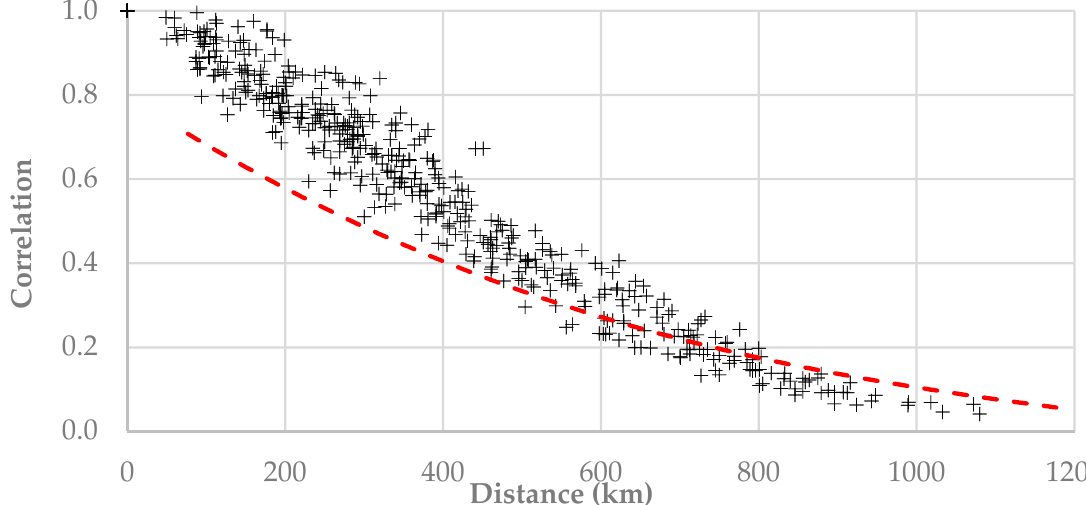
Figure 5. Pearson’s correlation coefficient between nodes, with trend line adapted from [11] (p. 118). Correlation at closer distances is exaggerated due to nodes being the summation of multiple generators.